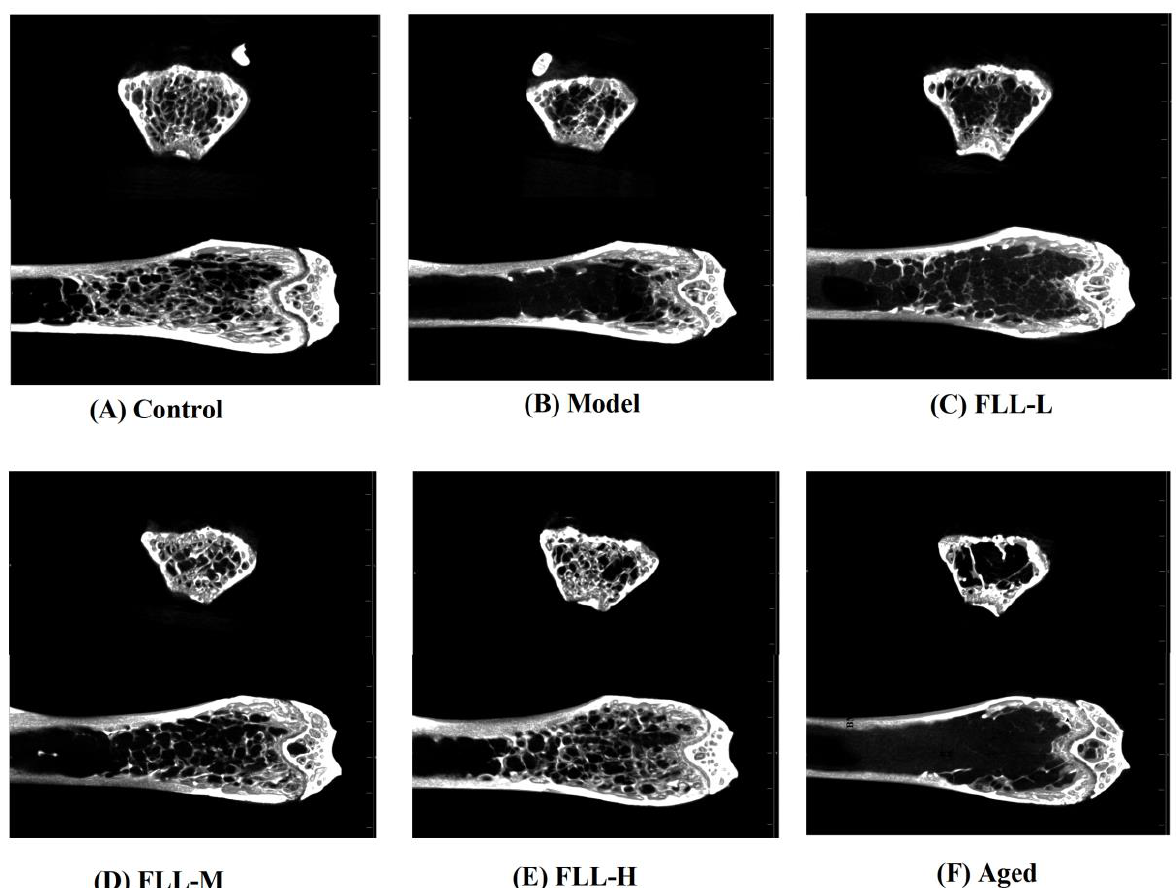
Figure 4. The micro-CT showed the effects of FLL on bone microstructure in the femurs of female mature ( A – E ) and aged mice ( F ). The 13-week-old Kunming female mice ( n = 8/group) and 8-month-old aged female mice ( n = 8) were orally administrated with vehicle, or FLL water extract at dosages of 1.75, 3.5 and 7 g/kg/d for 20 d. Meanwhile, D-gal injection (10 mg/kg/d) was combined with a low calcium diet (0.1%) to model the osteoporosis induced by oxidative stress in mice. At the end of the experiment, all mice were euthanized, and the right femurs were analyzed with micro-CT.